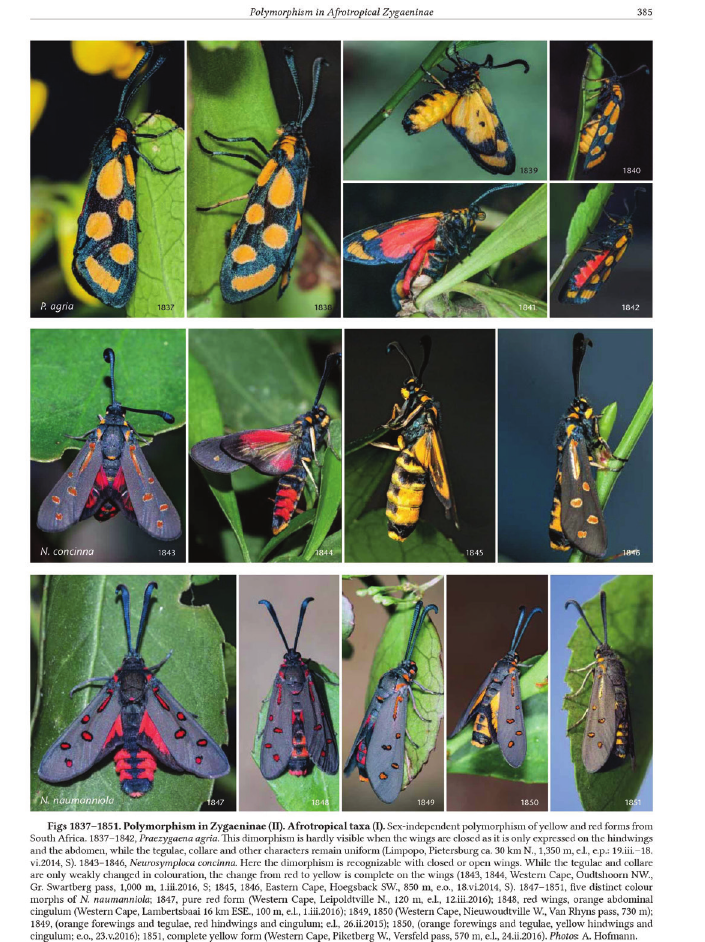
Figure 6. An example of the polymorphism in burnet moths on page 385 of the